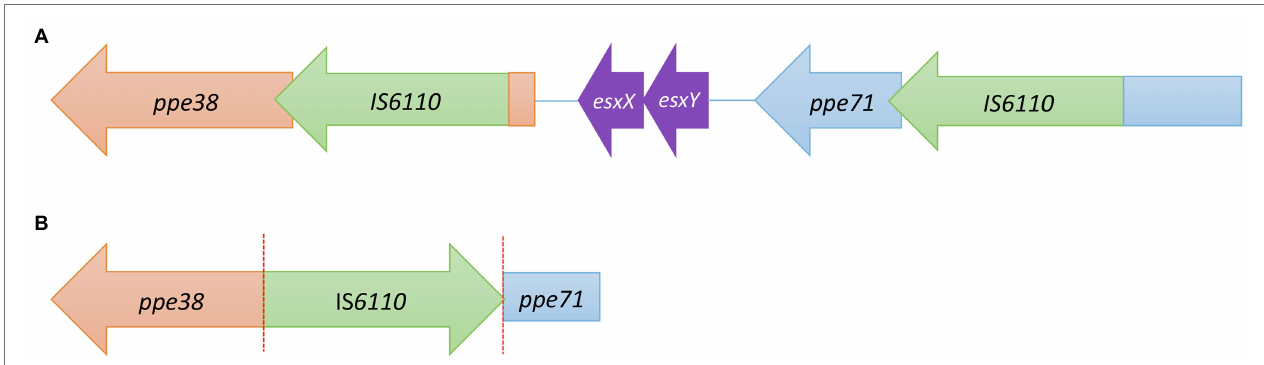
FIGURE 3 | (A) Configuration of the ppe38 locus in the MtZ strain. (B) Configuration of the ppe38 locus in the Beijing GC1237 strain. The red lines indicate a truncation of the